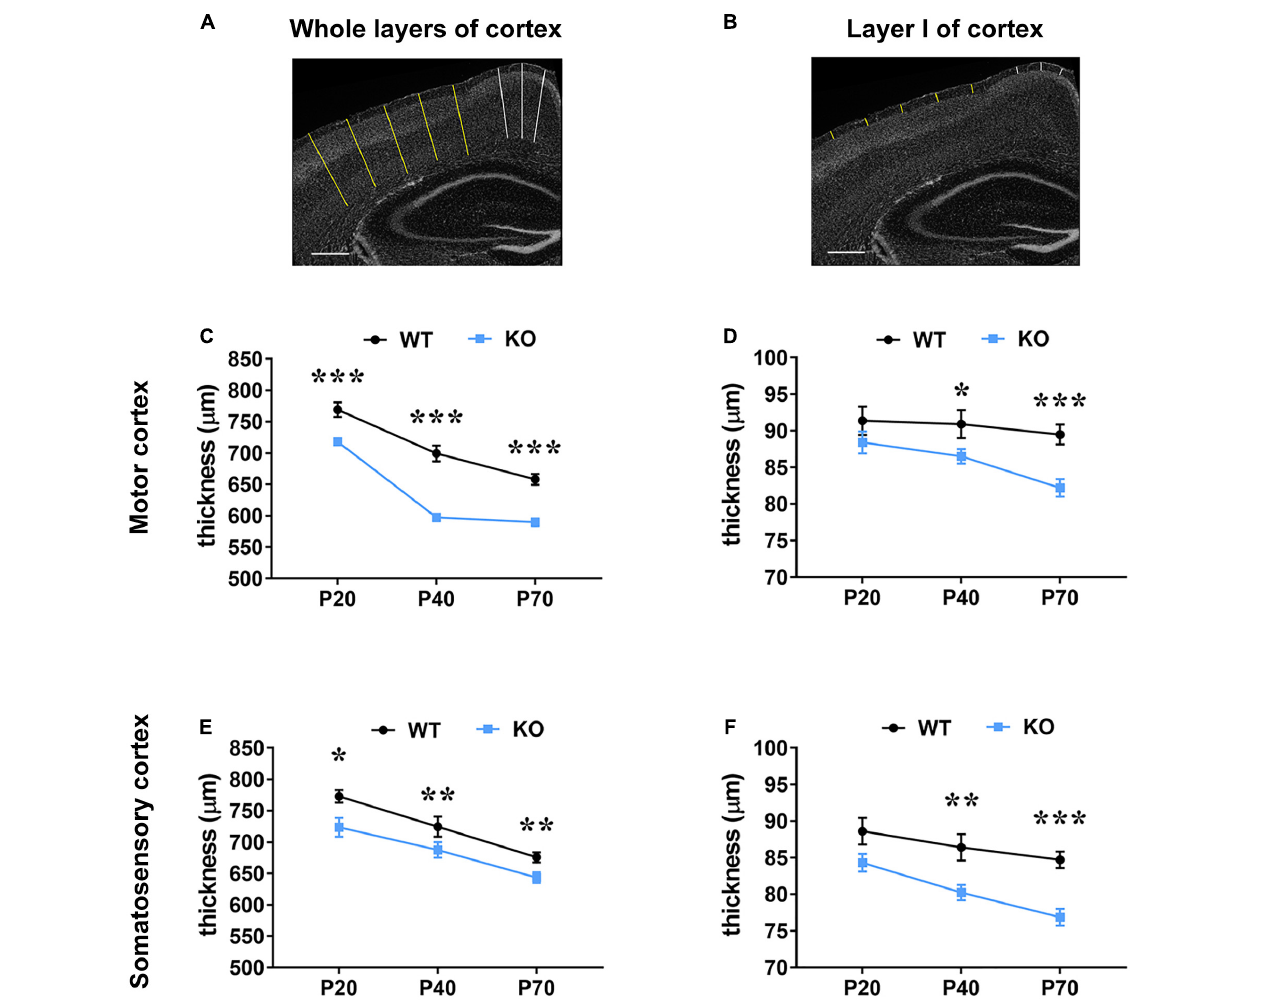
FIGURE 5 | Mecp2 deficiency causes a reduction of the thickness of the motor and somatosensory cortex, which correlates with astrocytic atrophy. (A,B) Representative images of brain coronal sections stained with DAPI. Traced lines were used to measure the thickness of whole layers (A) and layer I (B) in the motor (white) and somatosensory cortex (yellow). Original magnification: 4 × . Scale bar = 400 µ m. (C–F) The graphs depict changes in the thickness of whole cortical layers and layer I of the motor (C,D) and somatosensory cortices (E,F) of Mecp2 null mice compared to their WT littermates, at different ages. Data are represented as mean ± SEM. * p < 0.05, ** p < 0.01, *** p < 0.001 by Student’s t -test or Mann–Whitney test in accordance with data distribution. One-way ANOVA indicates a significant reduction in the thickness of whole layers of WT and KO motor and somatosensory cortices from P20 to P70 ( p < 0.001); analysis of layer I reports a significant reduction from P20 to P70 in KO motor ( p < 0.01) and somatosensory ( p < 0.001) cortices, but not in WT tissues. Measurements of WT and KO brains derived from at least three non-consecutive slices of at least three different animals per genotype (P20: N = 4/5 WT and N = 4/6 KO; P40: N = 3 WT and N = 5 KO; P70: N = 5 WT and N = 5